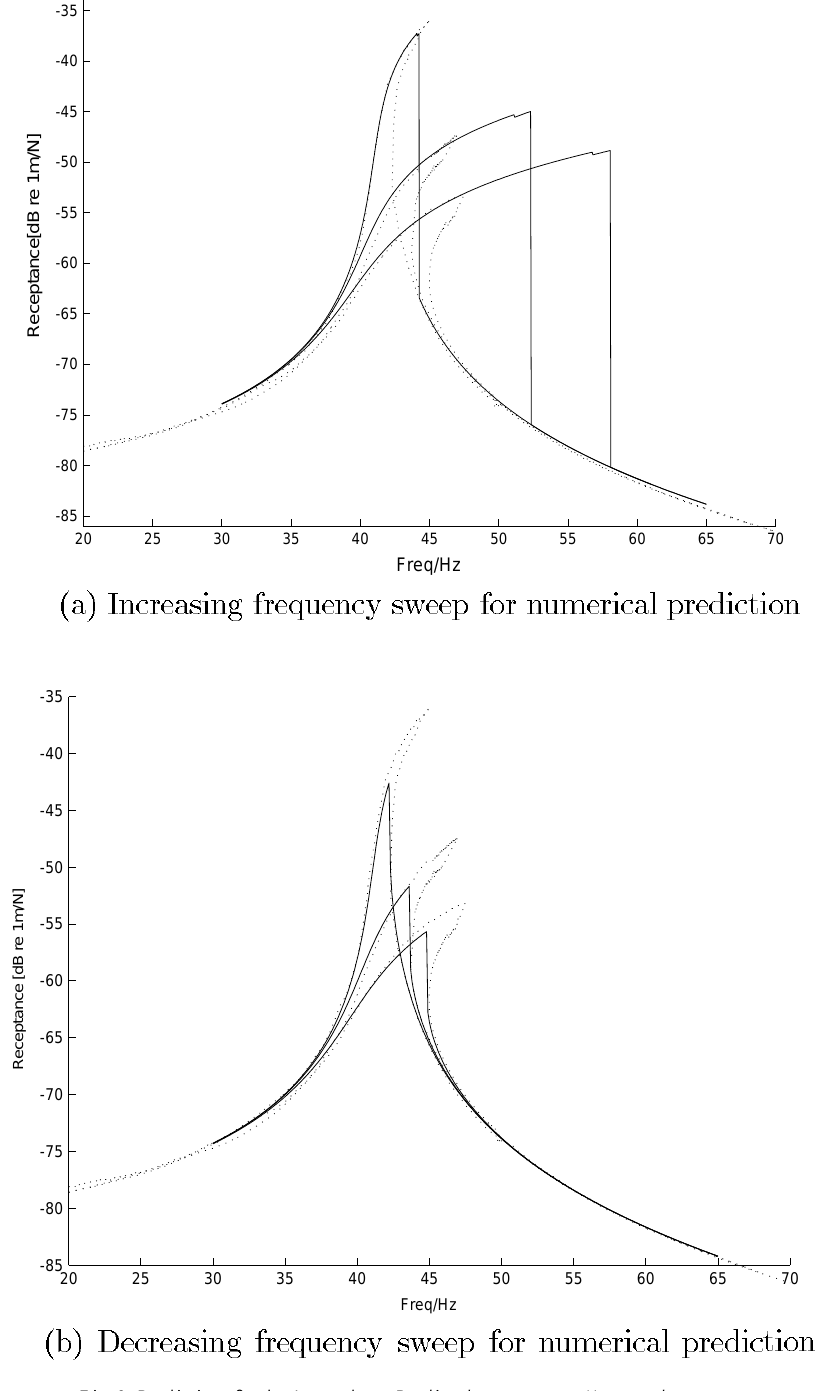
Fig. 6. Predictions for the 1st mode: Predicted response, ... Measured